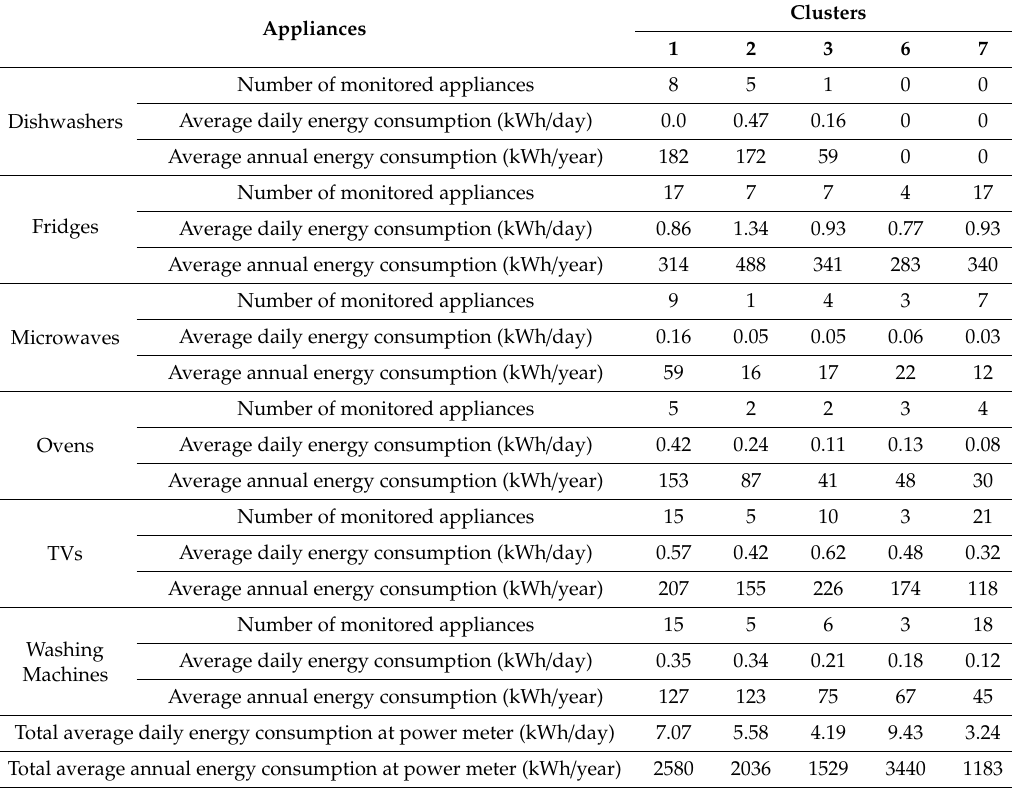
Table 7. Appliance energy consumption by type and by cluster.